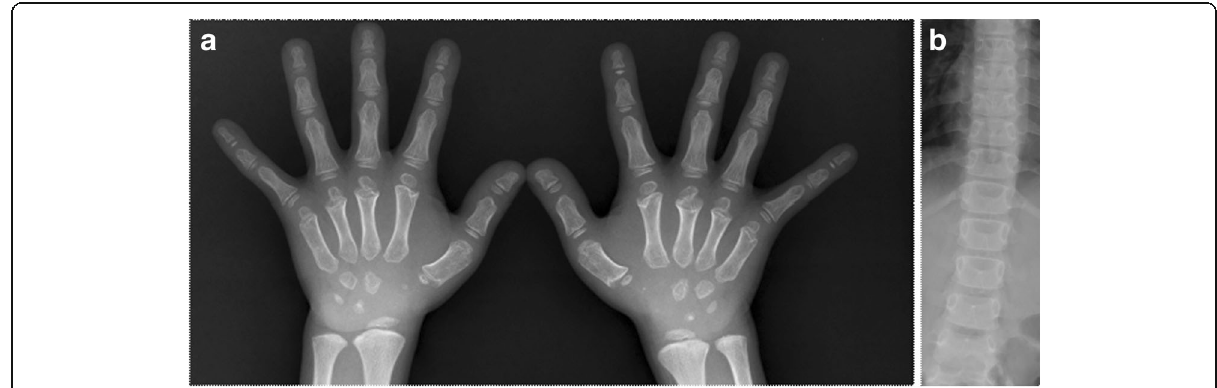
Fig. 1 a : Short bone deformity of both hands, delayed development of osteophytes. b : Mild lateral curvature of the lumbar